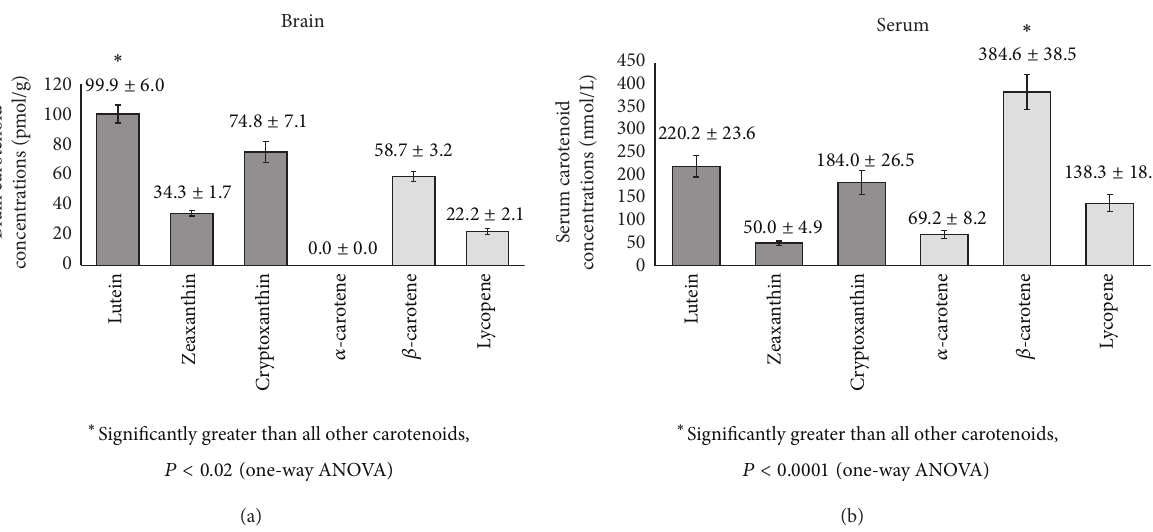
Figure 1: Mean ( ± SEM) concentrations of carotenoids ( trans isomers) in the brain (average of cerebellum frontal serum, occipital, and temporal cortices) of decedents from the Georgia Centenarian Study ( 𝑛 = 42 ). Dark gray bars indicate xanthophyll carotenoids. Light gray bars indicate